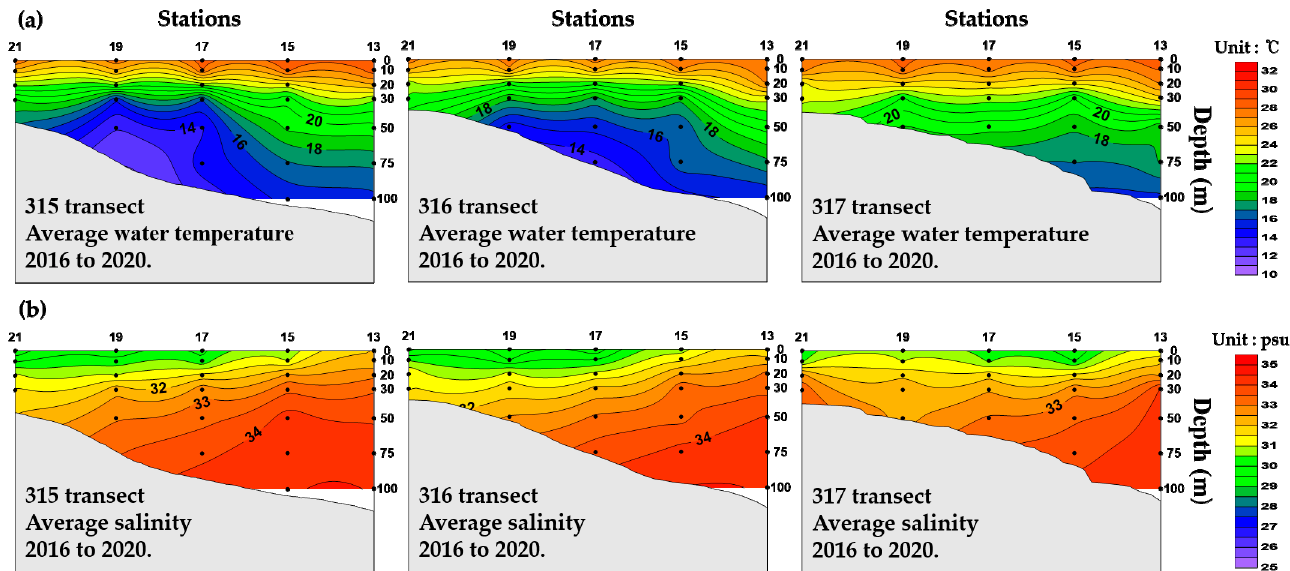
Figure 4. Vertical distribution of average surface temperatures ( a , °C) and average surface salinities ( b , psu) in the northern East China Sea from 2016 to 2020.